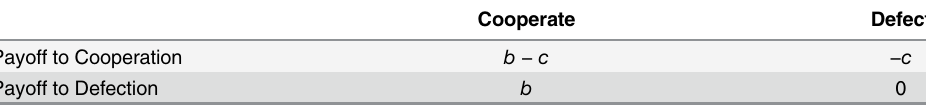
Table 1. Payoff Matrices of the Prisoner ’ s Dilemma Game. Cooperate Defect Payoff to Cooperation b − c − c Payoff to